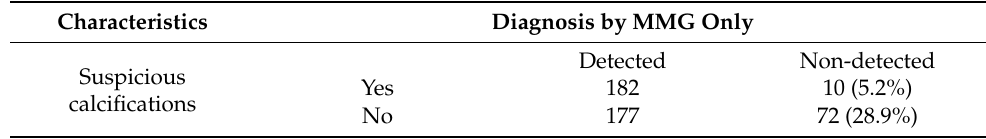
Table 2. Non-detected rate by MMG in patients with and without suspicious